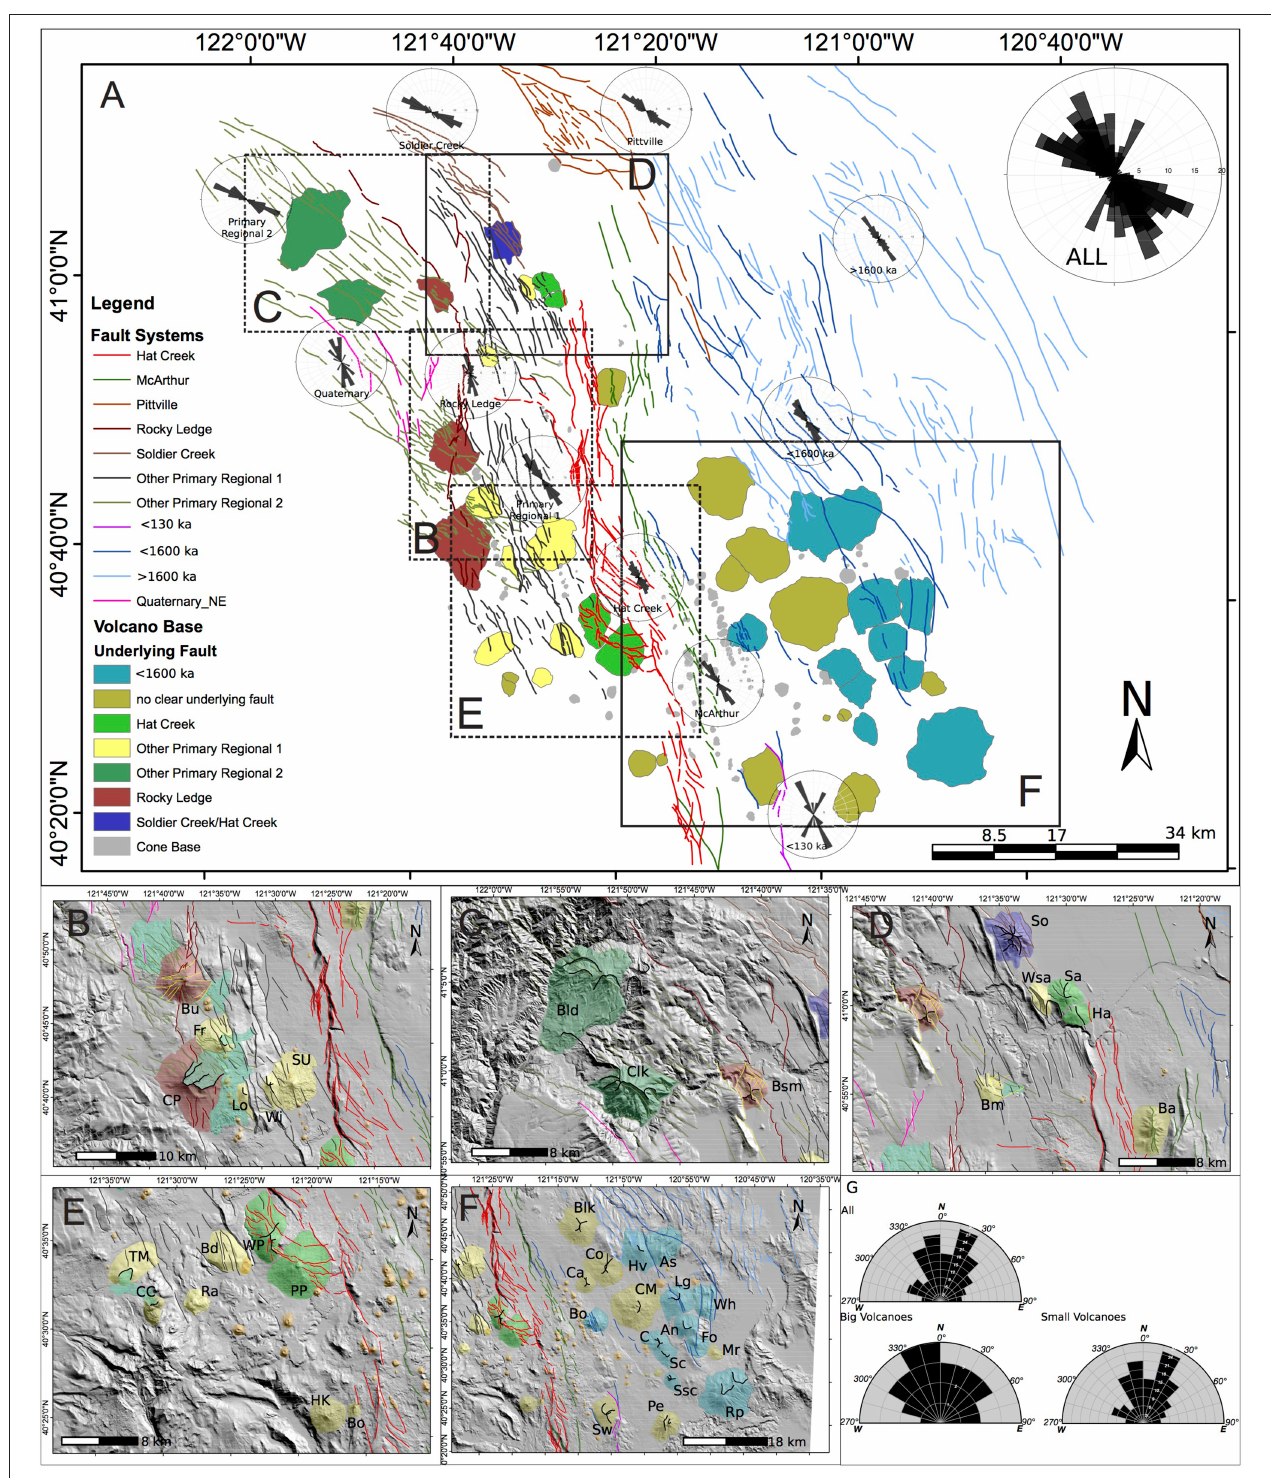
FIGURE 4 | Volcano-tectonic relationships in Hat Creek Graben region. (A) Base map showing fault systems, volcano bases color coded on fault system that mostly affects edifice, and water bodies; rose diagrams of fault strikes by fault system; and locations (squares) of hill-shaded maps (B–F) showing fault traces and effects on edifice: edifice instability and collapse, edifice disintegration, and splitting. (G) Rose diagrams of volcano base elongations for both big (cones, sub-cones, shields, and massifs) and small (small cones, small sub-cones, and small shields) volcano sub-groups, and all volcanoes. Dataset available in Supplementary Materials.